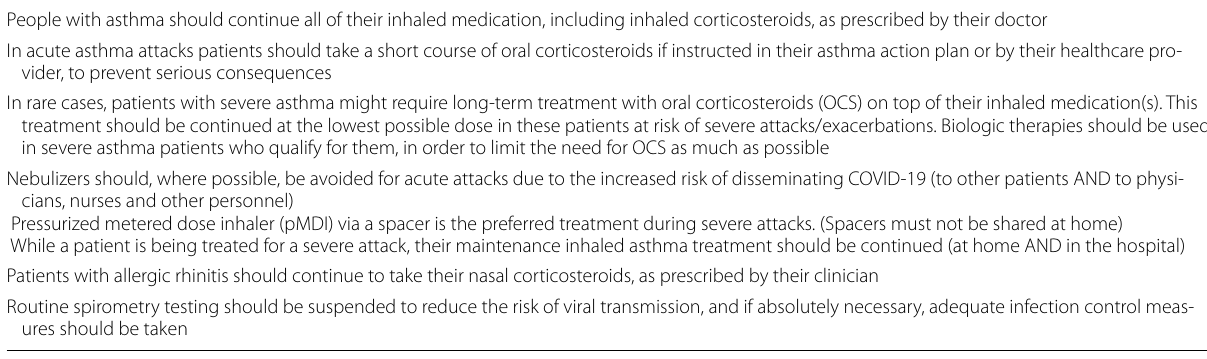
Table 3 Allergic rhino‑conjunctivitis‑specific recommendations from ARIA/EAACI (from: Bousquet et al. 2020) [37] With the current knowledge, in patients with COVID-19 infection, intra-nasal corticosteroid (including spray) can be continued in allergic rhinitis at the recommended dose Stopping local intra-nasal corticosteroid is not advised. Suppression of the immune system has not been proven and more sneezing after stopping means more spreading of the Coronavirus These recommendations are conditional since there is a paucity of data and they should be revised regularly with new